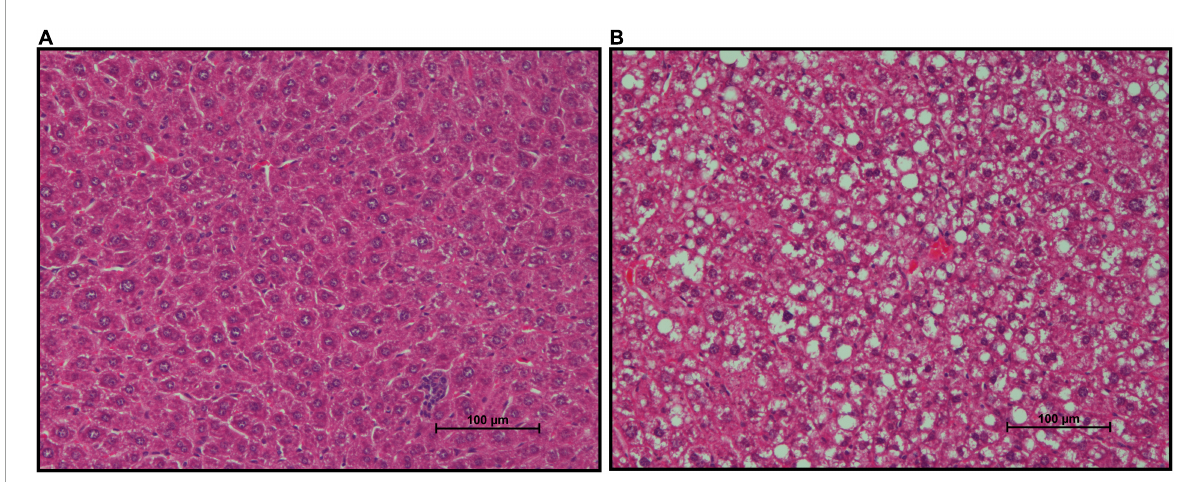
FIGURE7 Effects of diet on hepatic lipid accumulation. Representative images of Formalin-fixed Paraffin-Embedded (FFPE) livers from six mice fed either CON diet with no lipid deposition (A) or mSAD with lipid deposition (B) . Tissue sections were stained with Hematoxylin and Eosin (H&E). Scale bars at the bottom right of images represent 100 µ